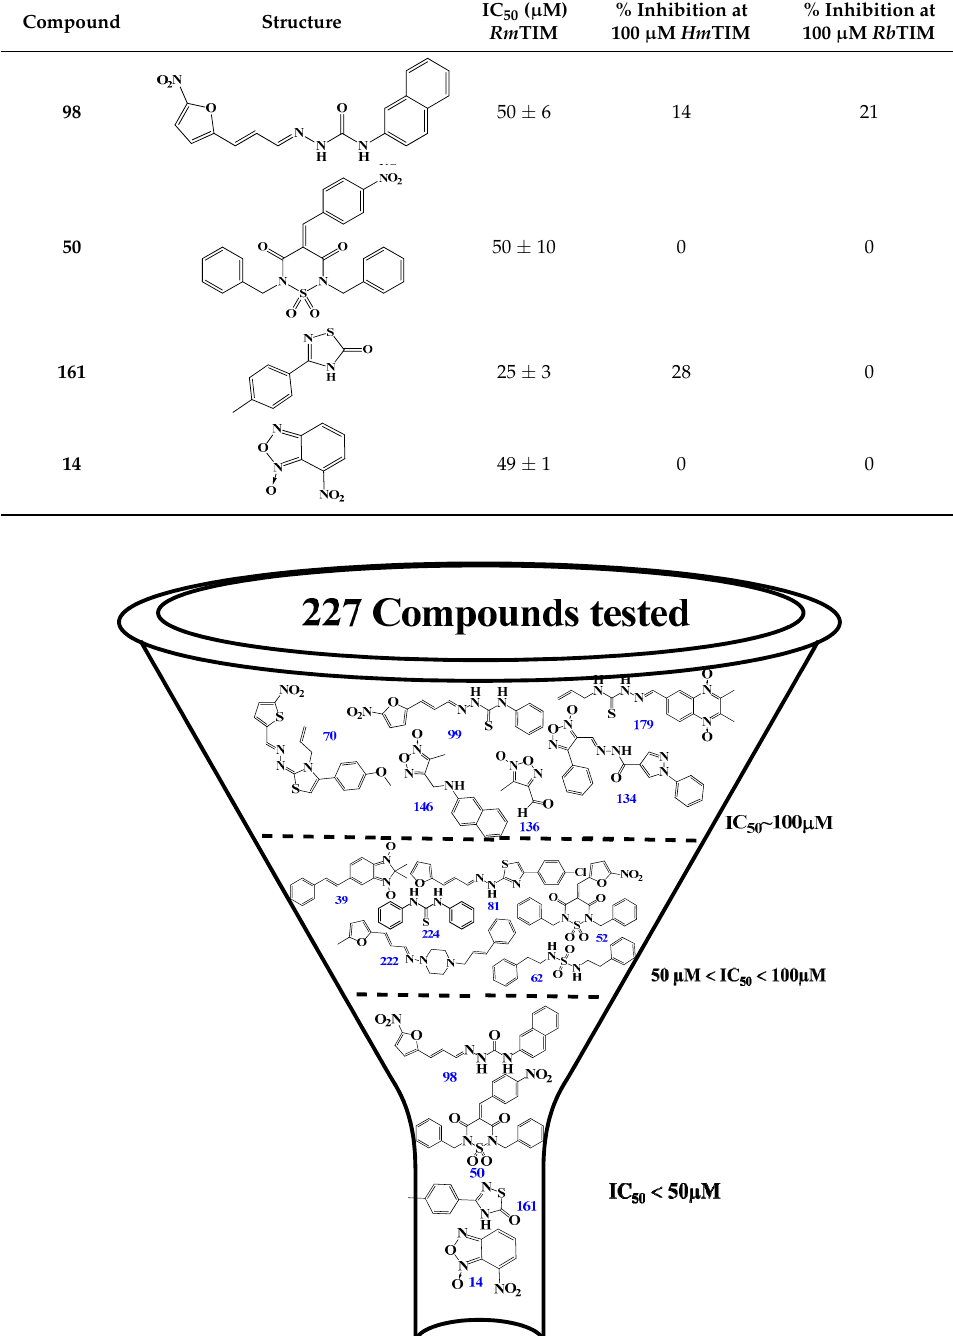
Table 1. IC 50 values of the most active compounds against Rm TIM and percentages of inhibition for human ( Hm TIM) and rabbit ( Rb TIM) at 100 µ M.